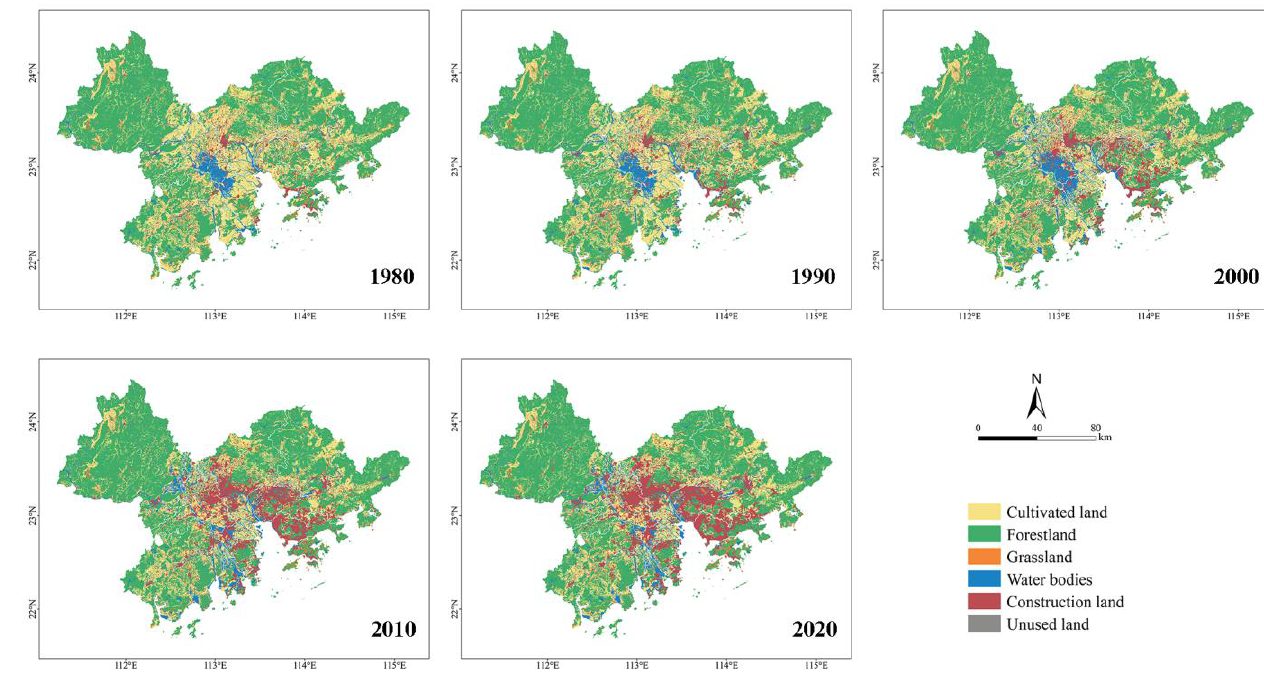
Figure 2. LUCC in the GBA from 1980 to 2020.